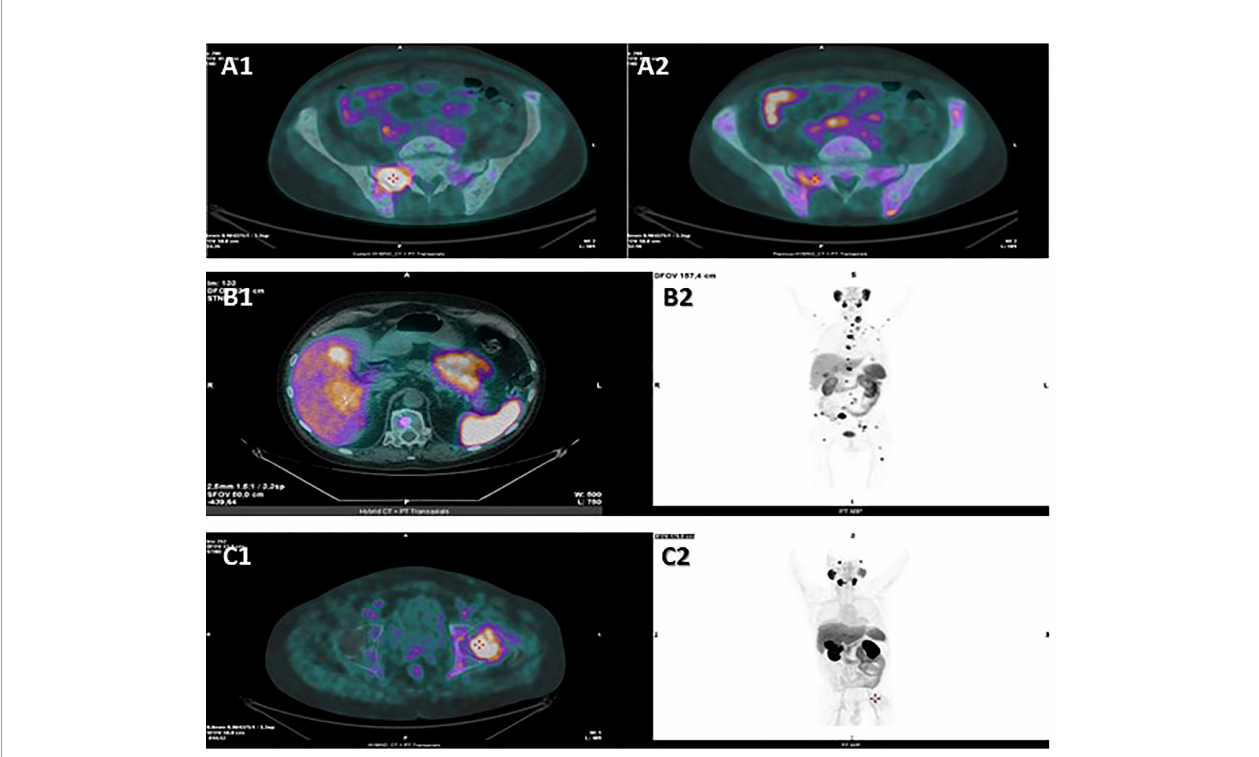
FIGURE 2 | Hybrid CT + PET transaxial images from 18F-FDG PET/CT (A1) and from 18F-PSMA-PET/CT (A2) examinations performed by patient 1 in September 2021, hybrid CT + PET transaxial (B1) and PET MIP total-body (B2) images from 18F-PSMA-PET/CT examination performed by patient 2 in October 2021, hybrid CT + PET transaxial (C1) and PET MIP total-body (C2) images from 18F-PSMA-PET/CT examination performed by patient 3 in January 2022. PSMA-PET scan performed by patient 1 revealed an intense tracer uptake in the prostate and in several bone lesions, such as in the right ala of the sacrum (A2) , while the hepatic lesions showed no tracer uptake. The following FDG PET scan revealed high FDG uptake in the liver and in several bone lesions, such as in the right ala of the sacrum (A1) . PSMA-PET scan performed by patient 2 revealed high tracer uptake in the liver (B1, B2) , bone (B2) and lymph nodes (B2) . PSMA-PET scan performed by patient 3 showed tracer-avid foci in the prostate and in several osteoblastic lesions, such as in the left femur head (C1, C2) , while no uptake was detected in the abdominal lymphadenopathies (C2) . CT, computed tomography; PET, positron emission tomography; FDG, fl uorodeoxyglucose; PSMA,prostate- speci fi c membrane antigen; MIP, maximum intensity